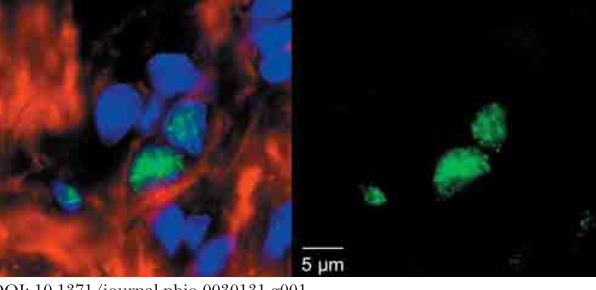
Figure 1. Islet-1-Positive Cardioblast in the Right Ventricular Chamber of the Neonatal Rat Heart Islet-1 nuclear staining depicted in green, nuclear staining in blue, myocyte marker staining in red. The left panel shows triple staining; the right panel shows single staining for Islet-1